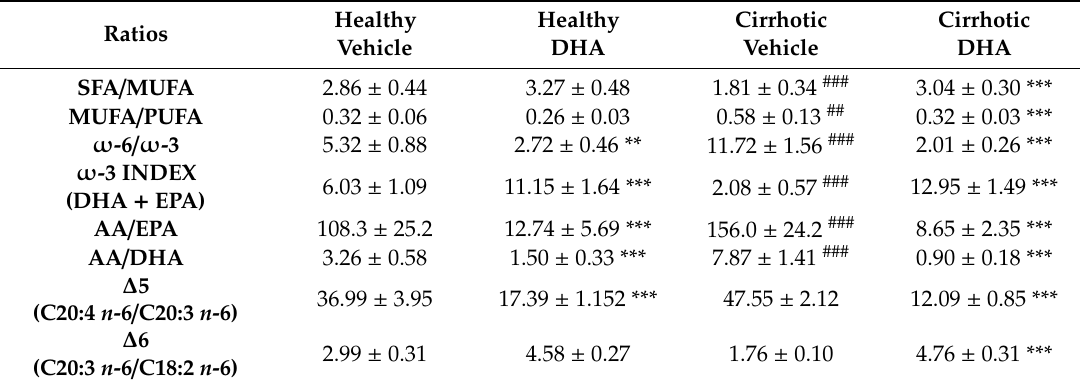
Table 2. E ff ects of DHA administration on hepatic fatty acid ratios in healthy and cirrhotic rats.